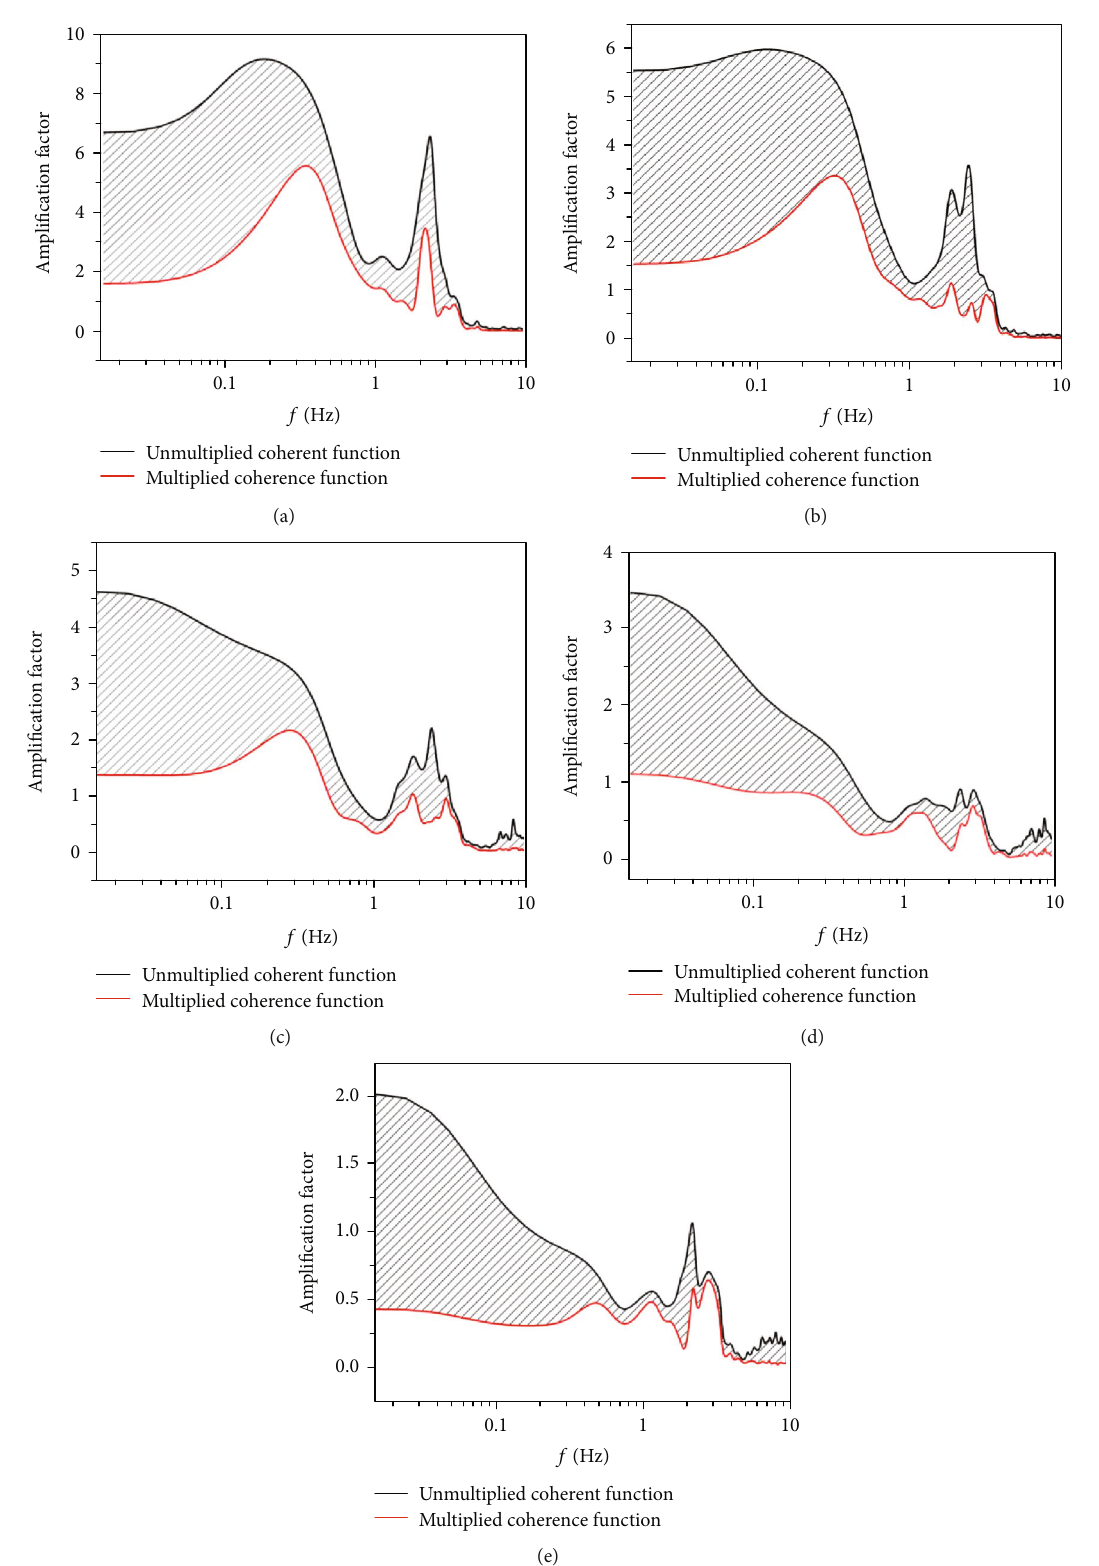
Figure 8: Ampli fi ed spectrum of the site response of the unmultiplied coherent function and multiplied coherent function (Model for the surface with water): (a) EL-1 situation, (b) EL-2 situation, (c) EL-3 situation, (d) EL-4 situation, and (e) EL-5